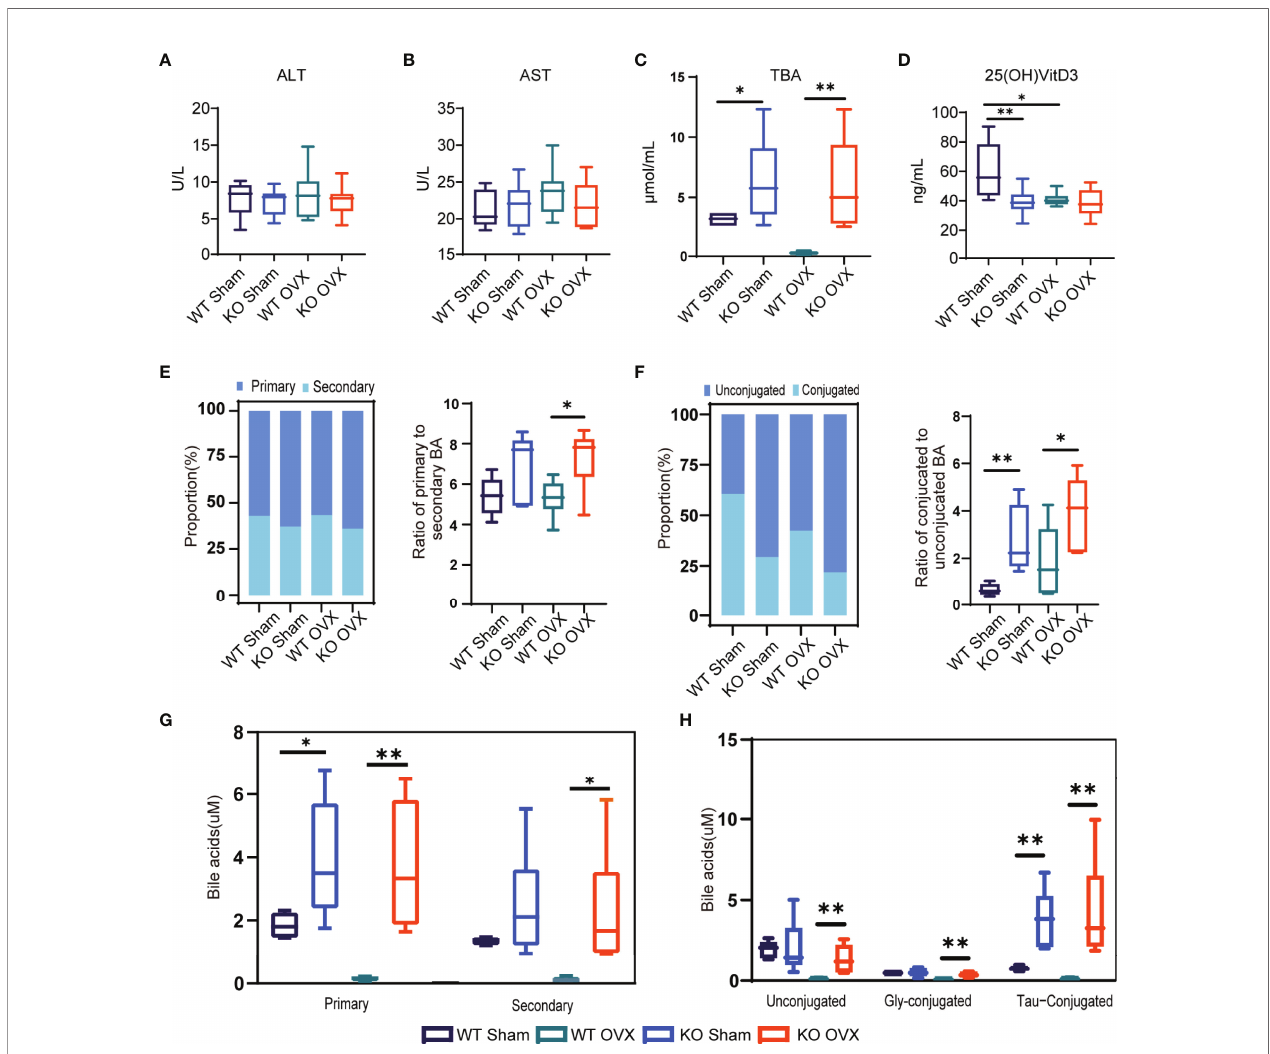
FIGURE 5 | NTCP de fi ciency increased the levels of bile acids (BAs) in the serum of mice. (A – D) Levels of ALT, AST, TBA, and 25(OH)D3 in serum of WT SHAM, KO SHAM, WT OVX, and KO OVX mice. n = 6 mice per group. (E) Stack bar plot representing the proportion of total primary and secondary BAs and box and whisker plots for the primary to secondary BAs ratio. (F) Stack bar plot representing the proportion of total conjugated and unconjugated BAs and box and whisker plots for the conjugated to unconjugated BAs ratio. (G) Primary and secondary BAs. (H) Concentrations of unconjugated, Gly-conjugated, and Tau-conjugated BAs in serum. *, p < 0.05 and **, p <